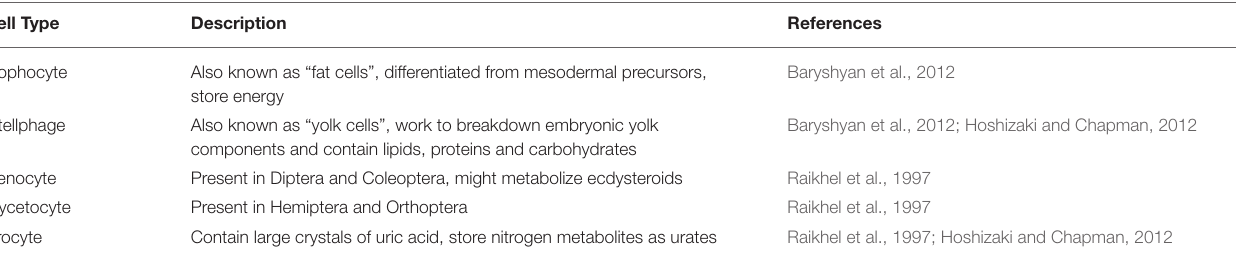
TABLE 2 | Cell types within insect fat body tissue.